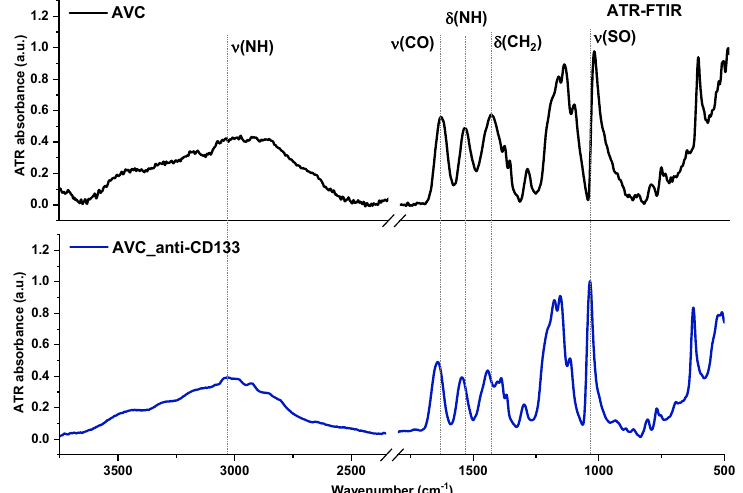
Figure 5. Attenuated total reflection–Fourier transform infrared spectroscopy (ATR-FTIR) spectra of the AVC ( upper ) and AVC with deposited solution of anti-CD133 ( bottom ).